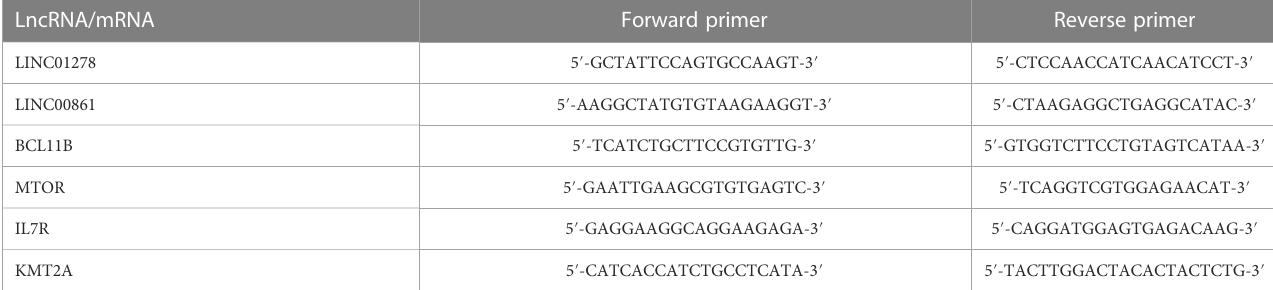
TABLE 1 Primer sequences used for qRT-PCR